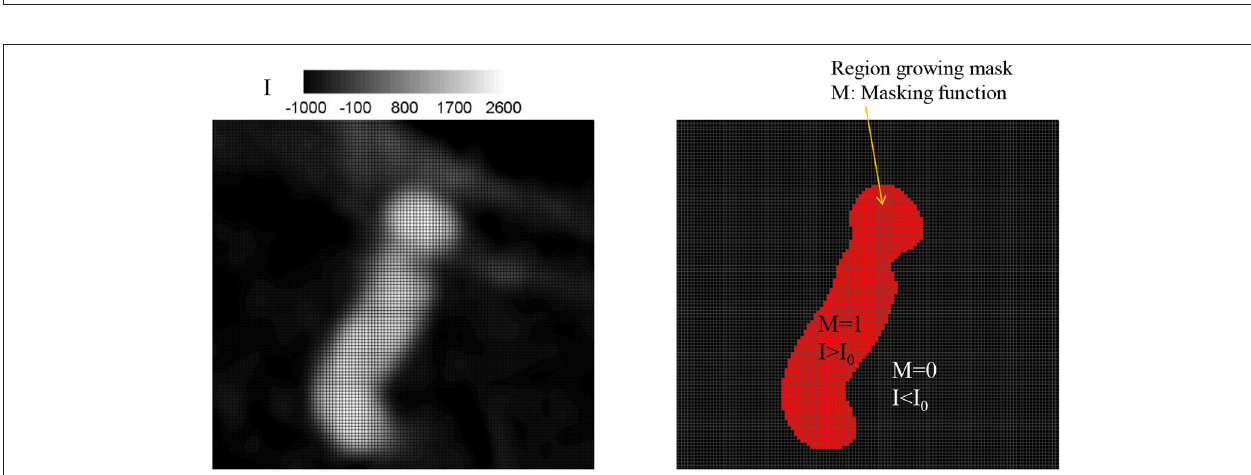
FIGURE 1 | Preparation of angiogram data for the automated flow simulation. (Left) 3D angiogram of vessels with a target aneurysm identified. (Right) Cartesian ROI set around the target aneurysm with the inflow vessel identified. Green dots represent the center of each face of the Cartesian ROI.